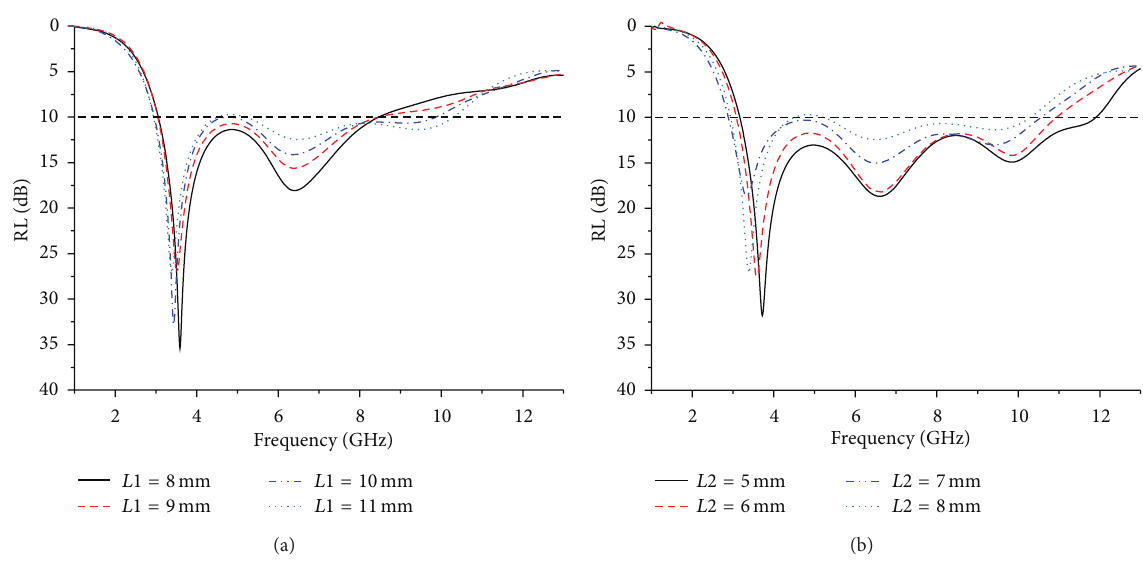
Figure 4: Return loss versus frequency (a) for different values of the parameter L1 (other parameters: G = 1mm, L2 = 8mm, Lg = 9 mm, W2 = 14 mm, W1 = 20 mm, d1 = 0, and d2 = 0) and (b) for different values of the parameter L2 (other parameters: G = 1mm, L2 = 11mm, Lg = 9 mm, W2 = 14mm, W1 = 20 mm, d1 = 0, and d2 = 0).